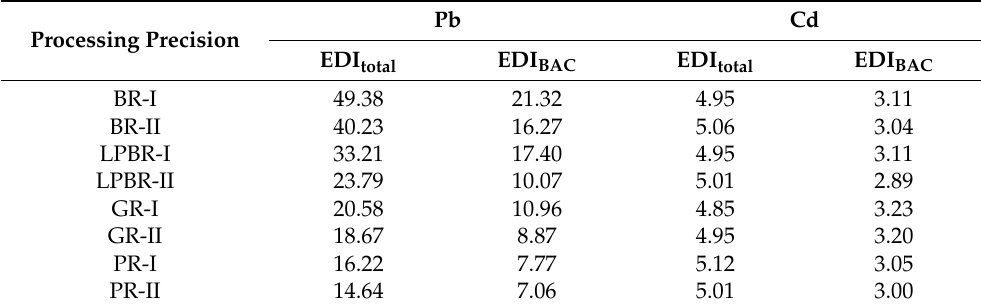
Table 3. Estimated daily intake (EDI, µ g kg − 1 BW day − 1 ) of based on total amount and bioaccessibil- ity of Pb and Cd by consuming rice with different polishing